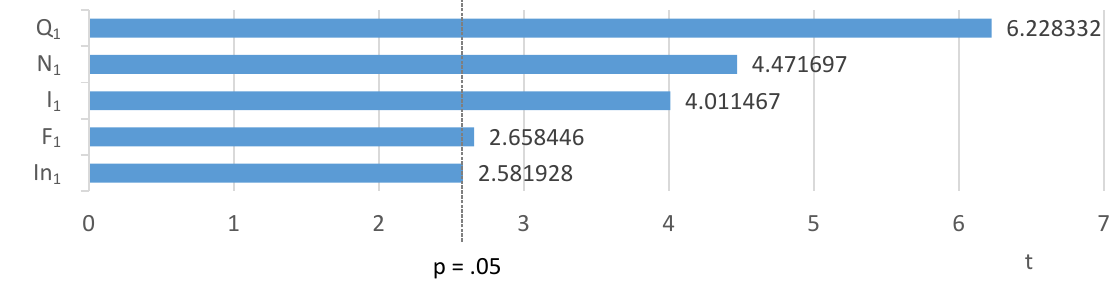
Figure 1. The significance of coefficients of the factors’ influence on the dynamics of GDP model (for agriculture)